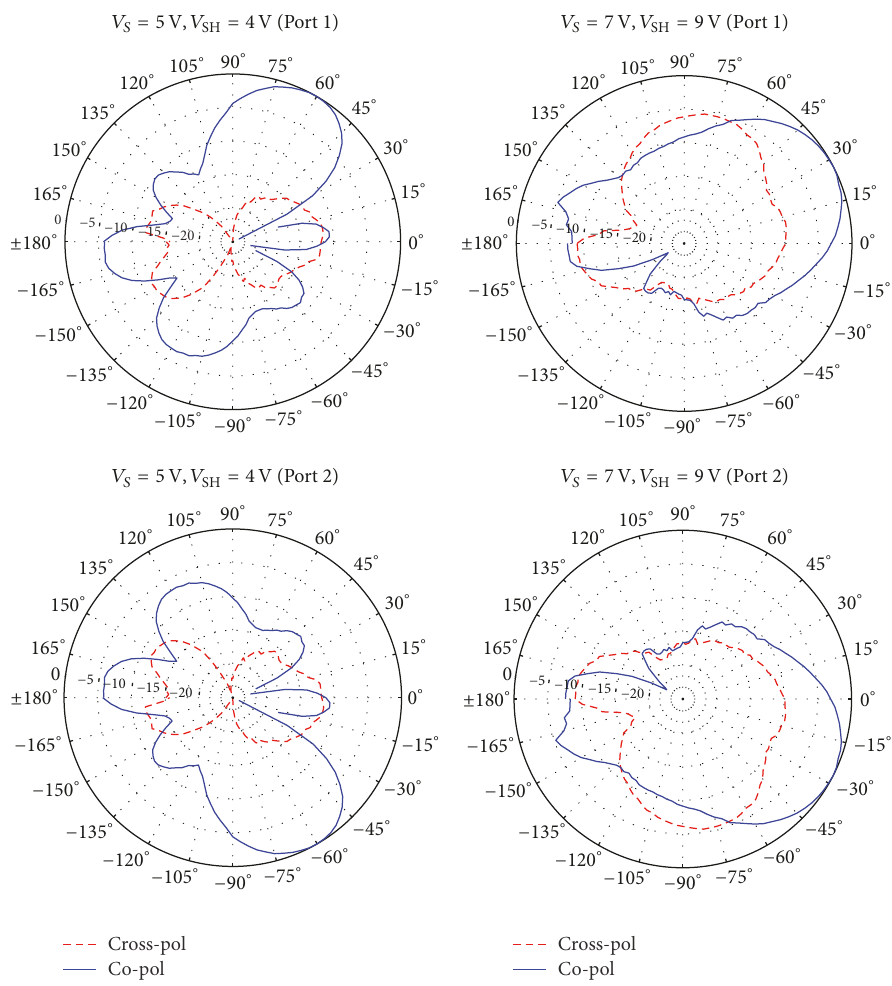
Figure 12: Co-pol and cross-pol of the beams at ±60 ∘ and ±30 ∘ . The miniaturization of the CRLH LWA maintains the linear polarization, with the cross-pol at least 5 dB lower than the co-pol.